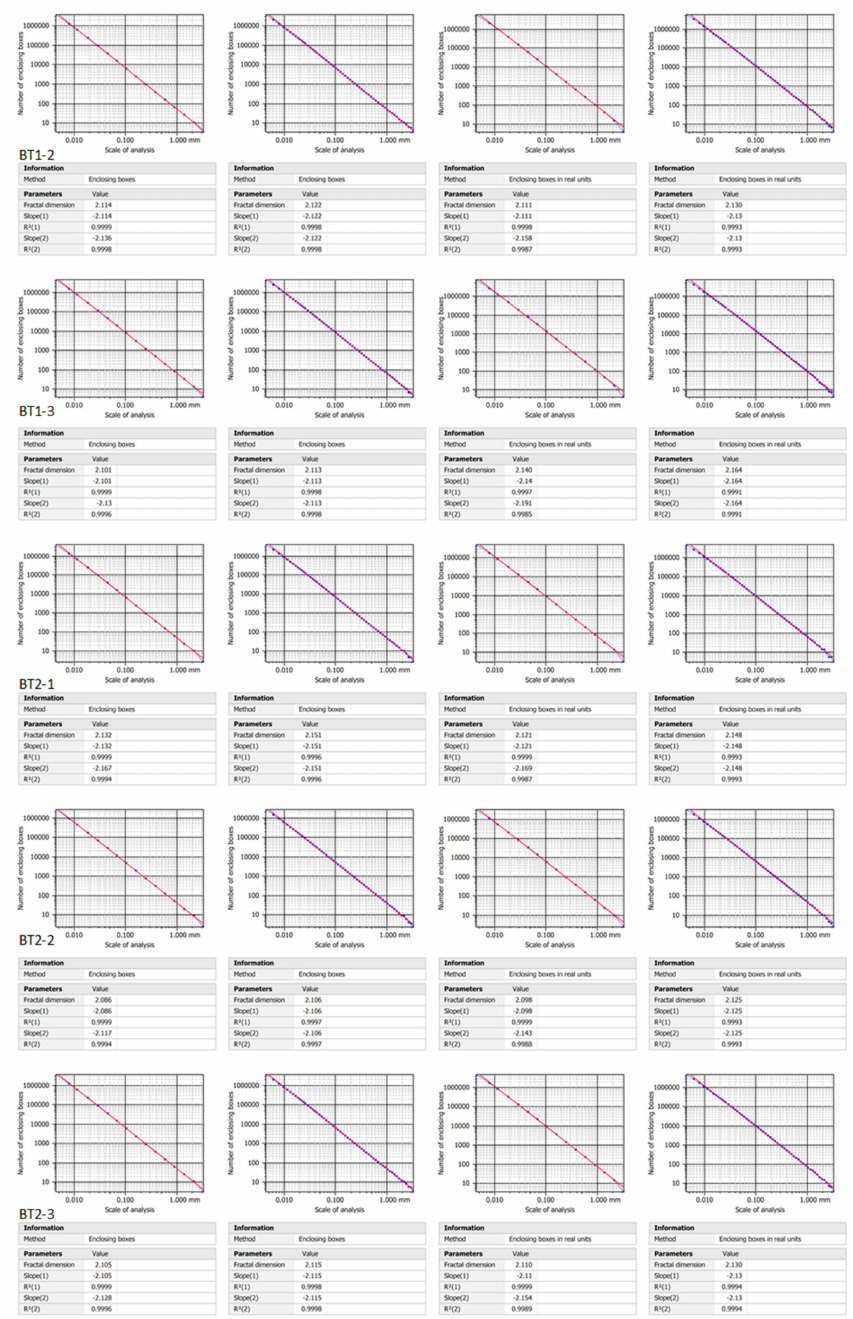
Figure A3. Fractal dimension Df